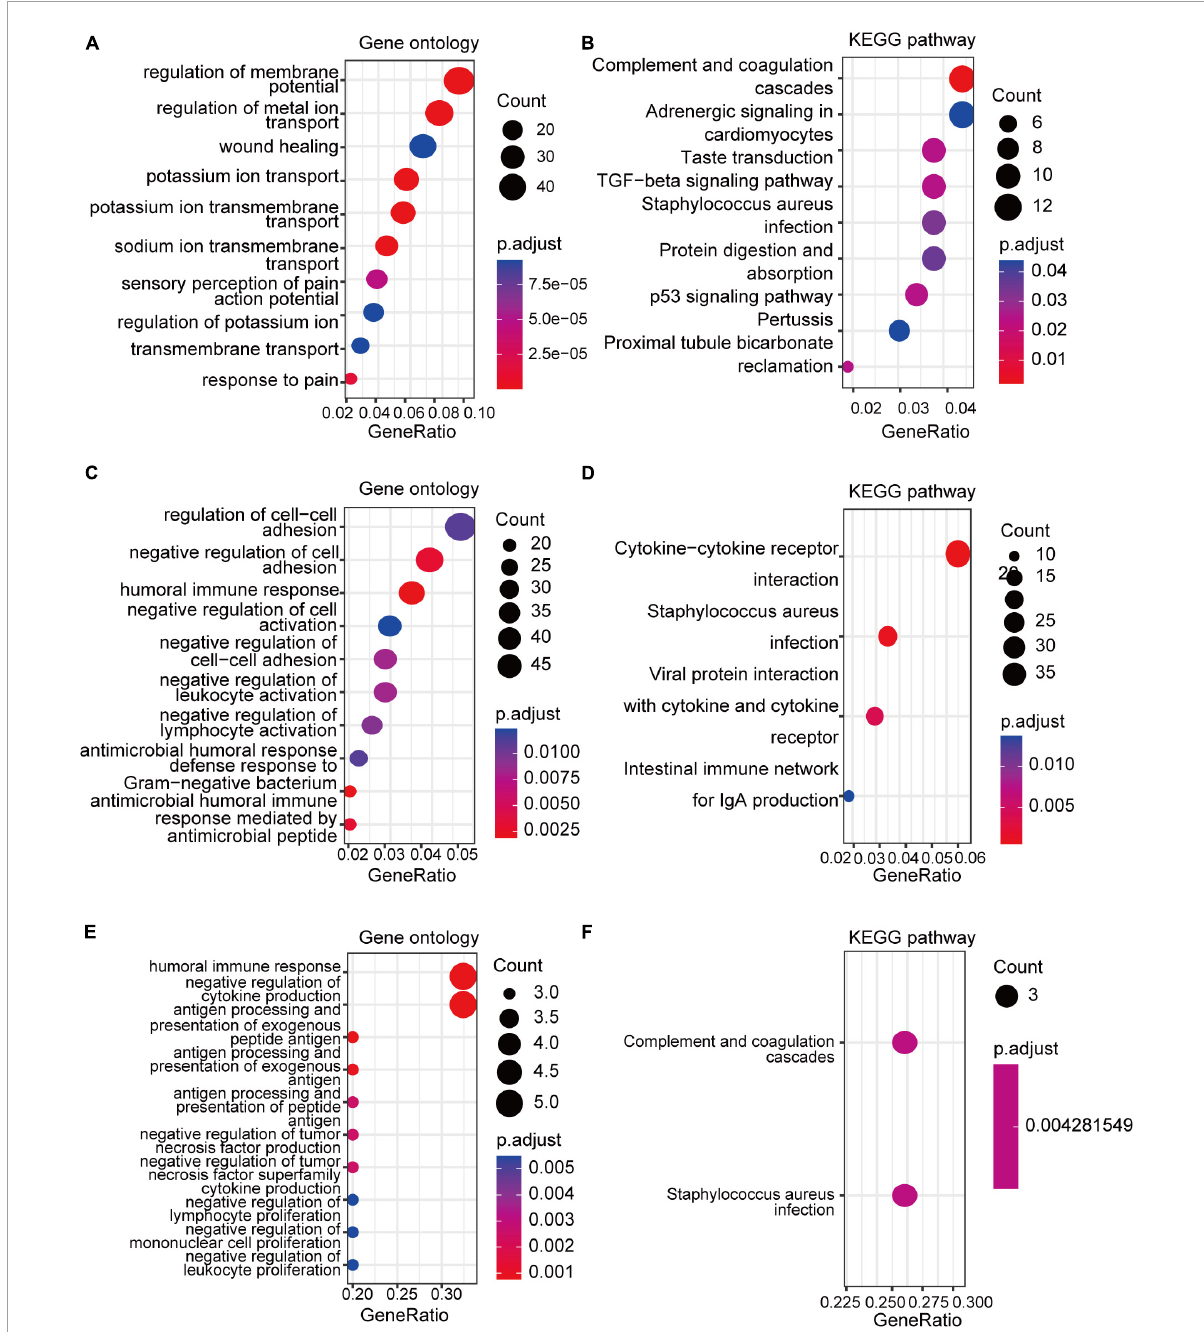
FIGURE3 GO and KEGG analyses of the DEGs and co-DEGs. (A,B) GO analysis and KEGG pathways analysis of the co-DEGs of the pain datasets. (C,D) GO analysis and KEGG pathways analysis of the DEGs of the aging dataset. (E,F) GO analysis and KEGG pathways analysis of the co-DEGs between the pain and aging datasets. GO, Gene Ontology; KEGG, Kyoto Encyclopedia of Genes and Genomes; DEGs, differential expressed genes; co-DEGs, common differential expressed genes.